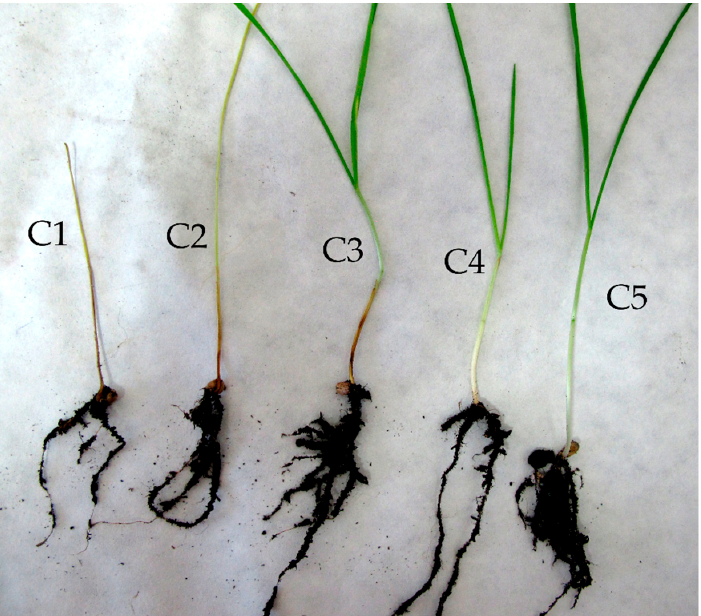
Figure 2. Five categories of plants depending on the degree of damage caused by the pathogen Fusarium culmorum. Categories 1 and 2 include necrotic (C1) and chlorotic (C2) germinated plants. Category 3 marks plants with symptoms like the browning of root neck (C3). Category 4—plants with a little brown spot on the top of the root neck (C4). Category 5 indicates plants with no visual symptoms of pathogen presence (C5). Categories 1–5—all plants emerged, categories 3–5—vital plants, category 5—symptomless